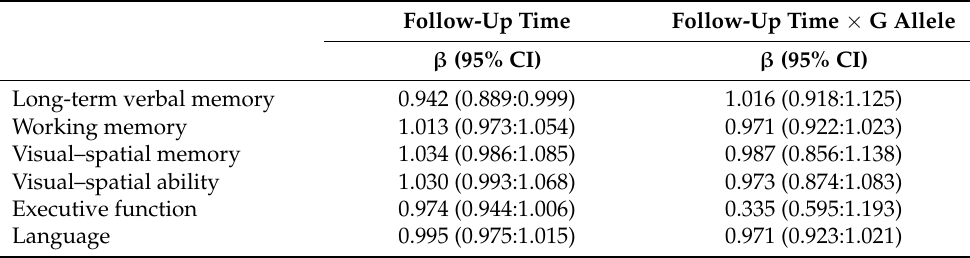
Table 4. Generalized estimating equations as a function of PER2 genotype over follow-up